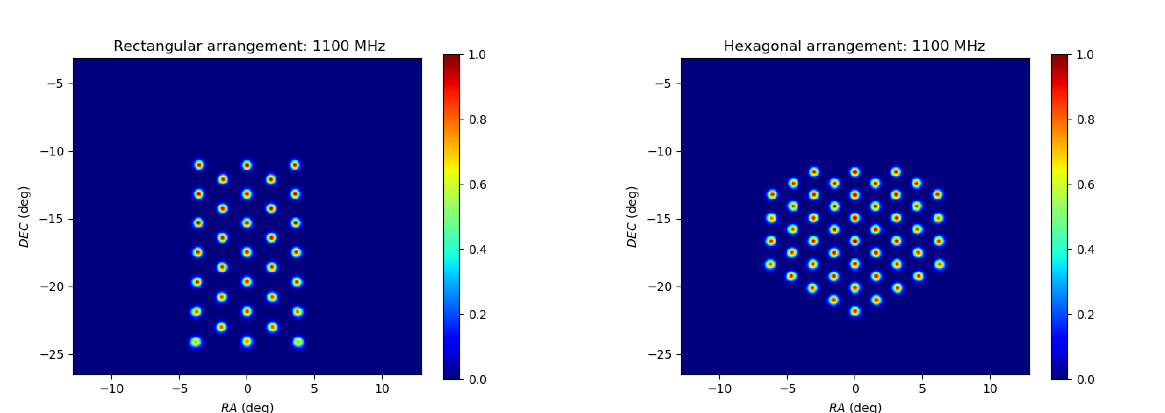
Figure 5. Beam pattern response for the Stokes parameters as a function of celestial coordinates, for the focal plane arrangement of a rectangular horn arrangement configuration (left) and for a hexagonal horn arrangement configuration (right). The colour scale on the right refers to intensity (dB) (Abdalla et al.